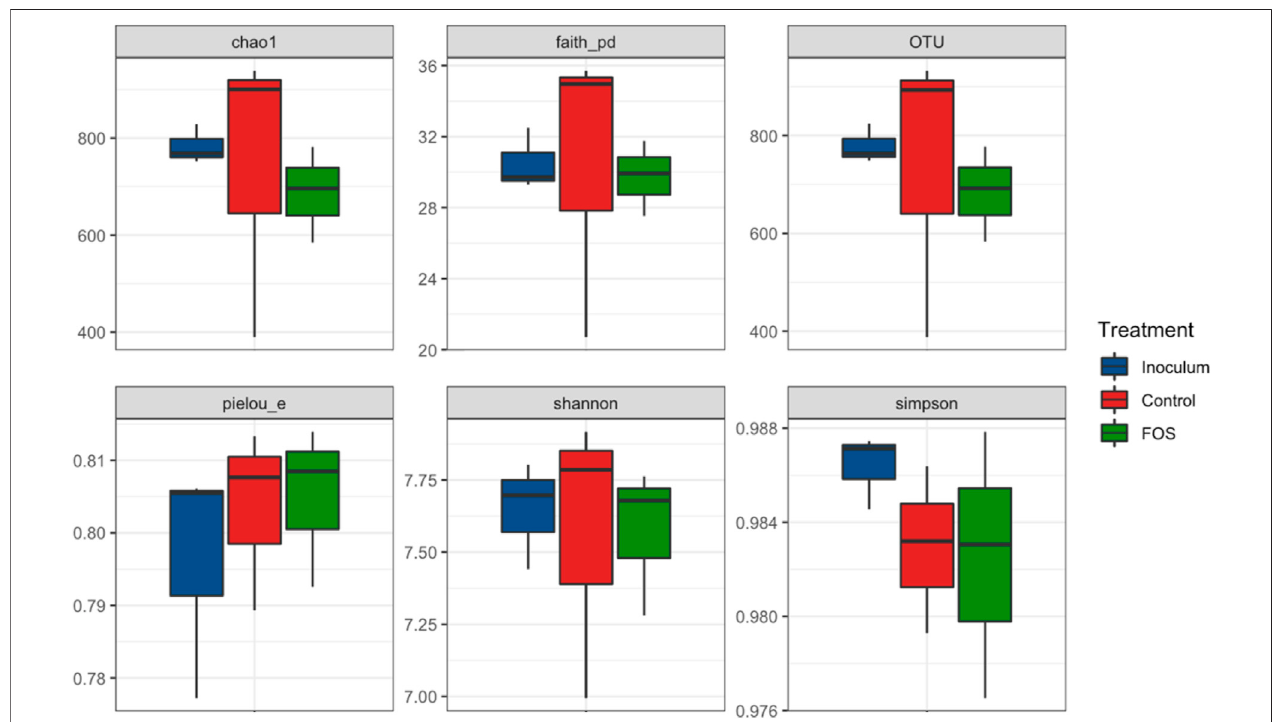
FIGURE 1 | Alpha diversity measures of rumen microbiota in the following treatments: inoculum, control, and FOS (Lv concentration 150 mg L − 1 ).